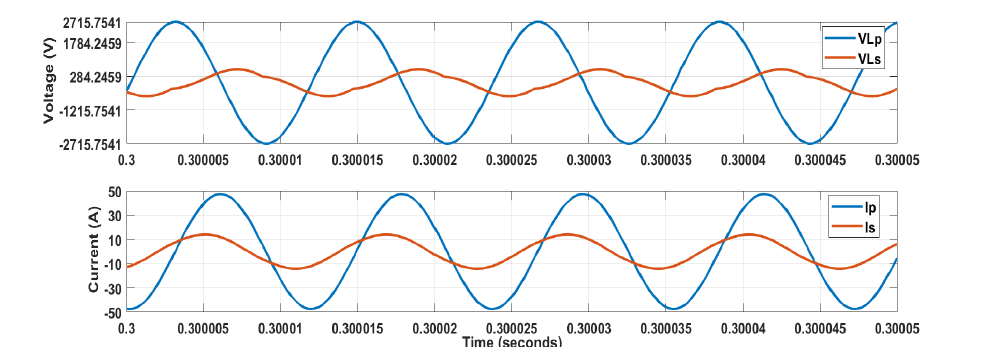
Figure 10. Voltage and current waveform of the inductive track at M = 14 µ H and f = 85